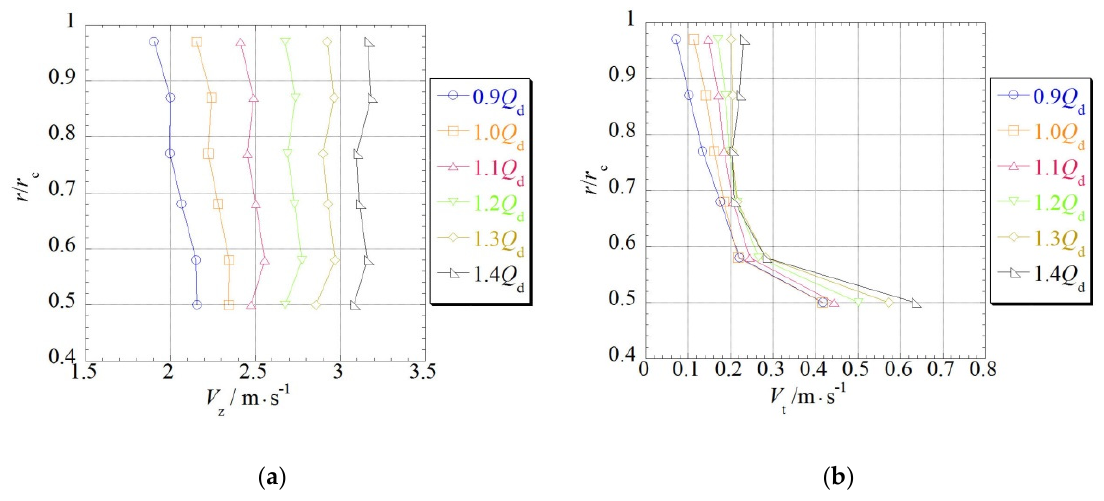
Figure 6. The front rotor axial velocity and circumferential velocity of original model: ( a ) Axial velocity; ( b ) Circumferential velocity.